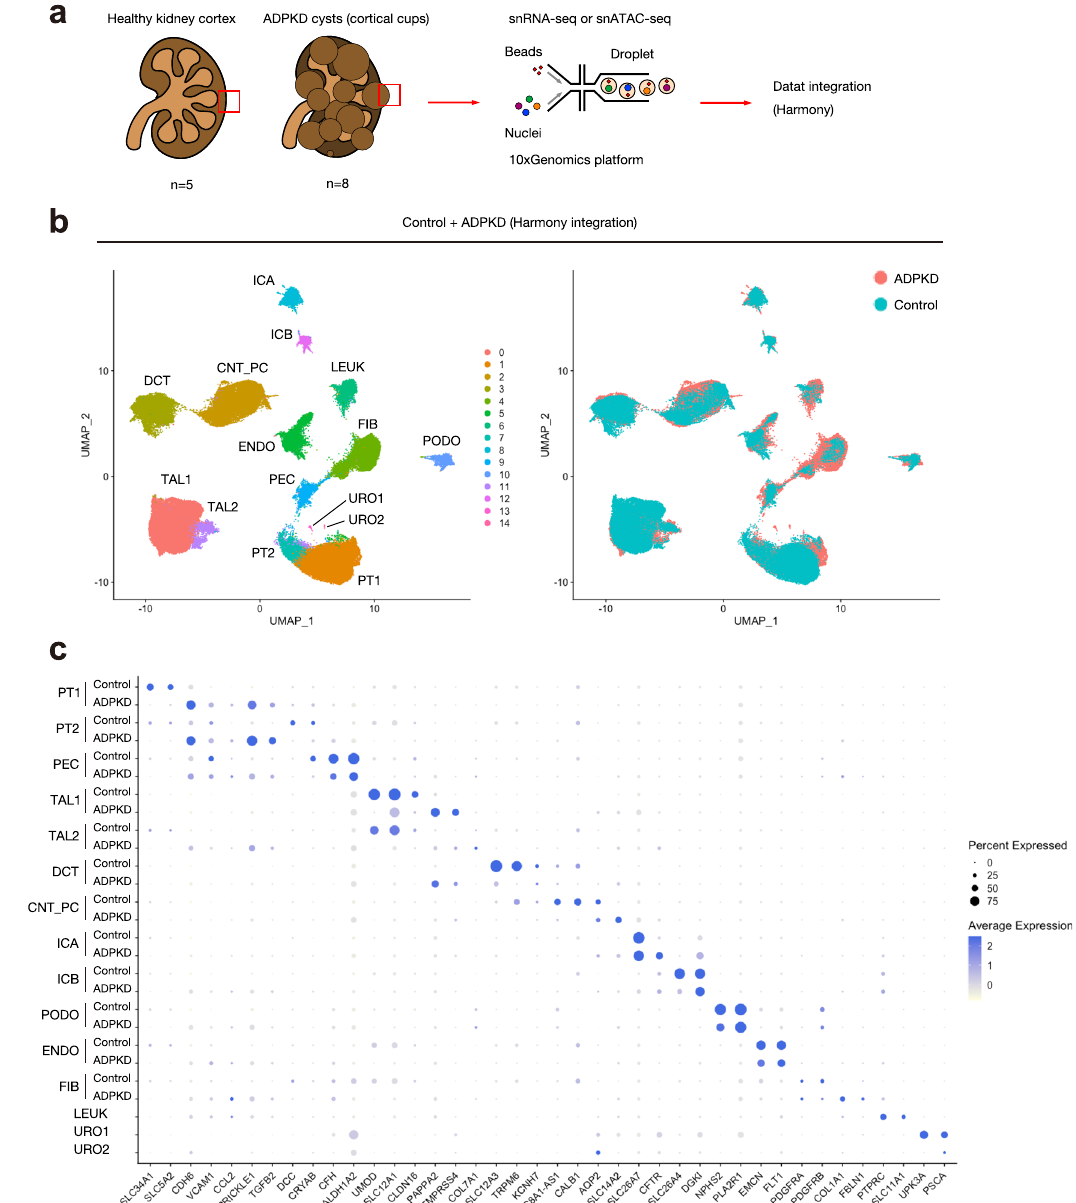
Fig. 1 | Single-nucleus transcriptional pro fi ling on human ADPKD kidneys. a Overview of experimental methodology. n =8 human ADPKD kidneys and n =5 controlkidneyswereanalyzedwithsnRNA-seqandsnATAC-seq.Batcheffectonthe integrated datasets was corrected with Harmony. See Method section for detail. b UMAPplot of integratedsnRNA-seqdataset with annotation by celltype(left) or diseasecondition(right).PTproximaltubule,PECparietalepithelialcells,TALthick ascending limb of Henle ’ s loop, DCT distal convoluted tubule, CNT_PC connecting